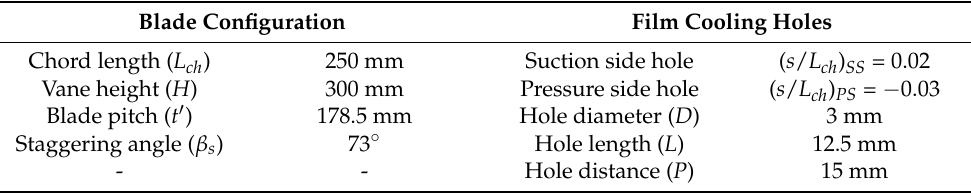
Figure 1. Computational domain with boundary conditions. Table 1. Film-cooled blade configuration, adapted from